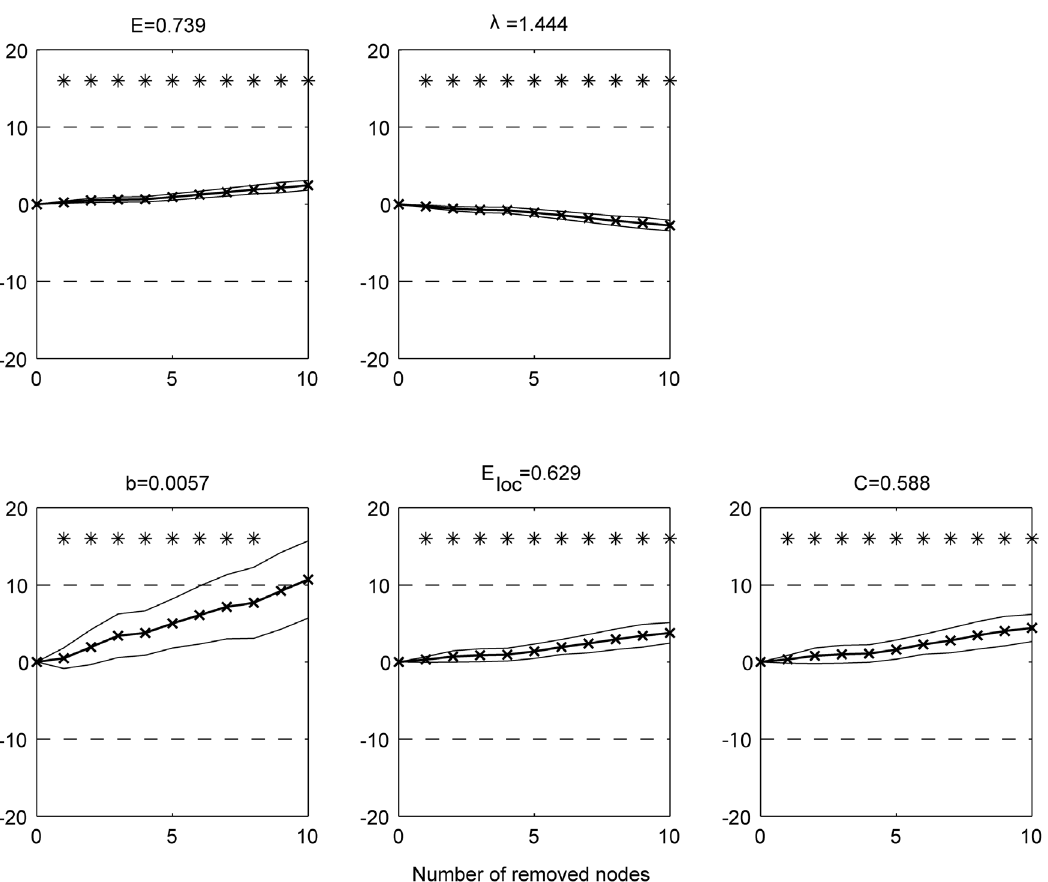
Fig. 8. Robustness to missing nodes for individual weighted networks. The relative change (%) to the value obtained when taking the intact network as the reference is shown. The nodes were removed based on their significance in the main effect of task (starting with the least significant ones). Full lines denote the mean (bold) + standard deviation of the metric across all